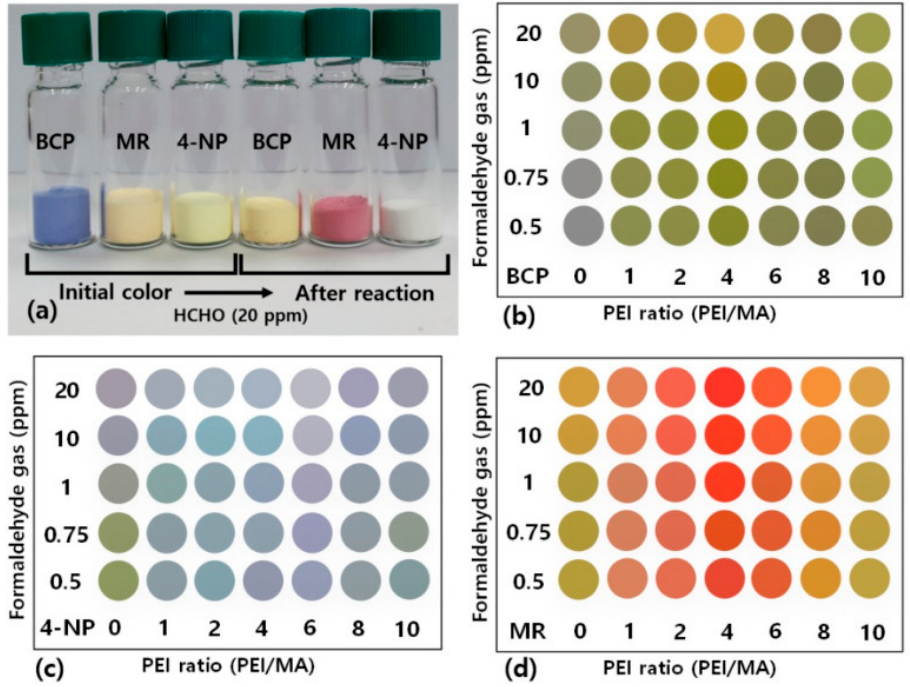
Figure 7. ( a ) Color changes observed by the naked eye for the bromocresol purple (BCP), 4-nitrophenol (4-NP), and methyl red (MR) colorimetric sensors when exposed to formaldehyde gas (20 ppm). Colorimetric responses ( ∆ RGB values) of ( b ) BCP, ( c ) 4-NP, and ( d ) MR sensors prepared with various PEI/PSMA ratios (0–10) on exposure to 20 ppm formaldehyde gas [102]. (Copyright (2020) Multidisciplinary Digital Publishing Institute).